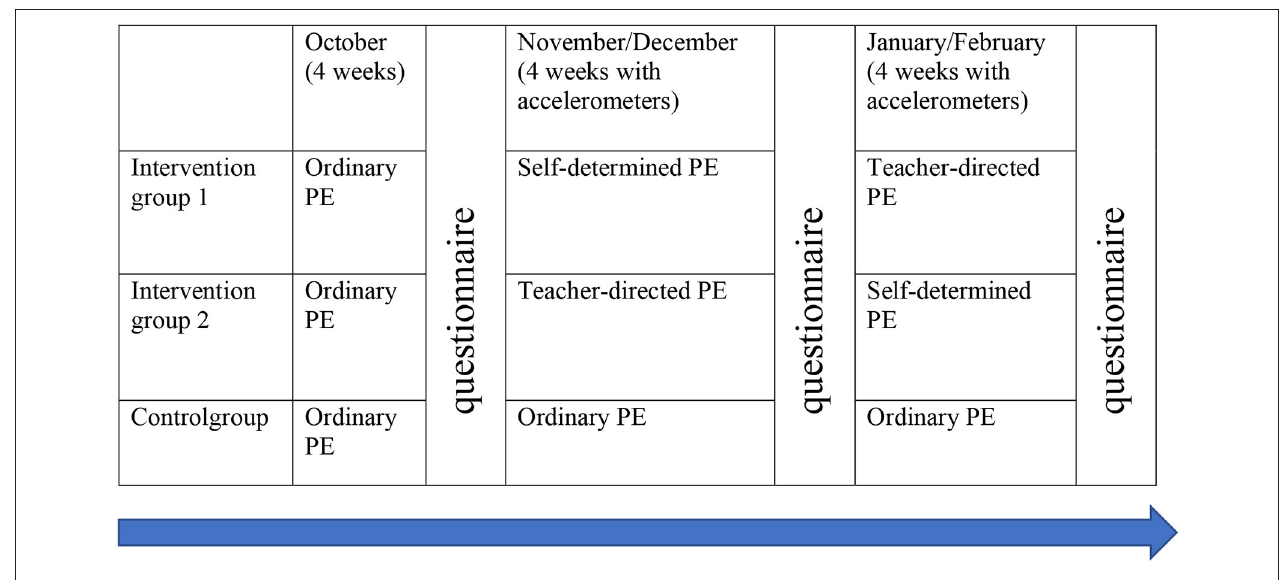
FIGURE 1 | The organization of the data